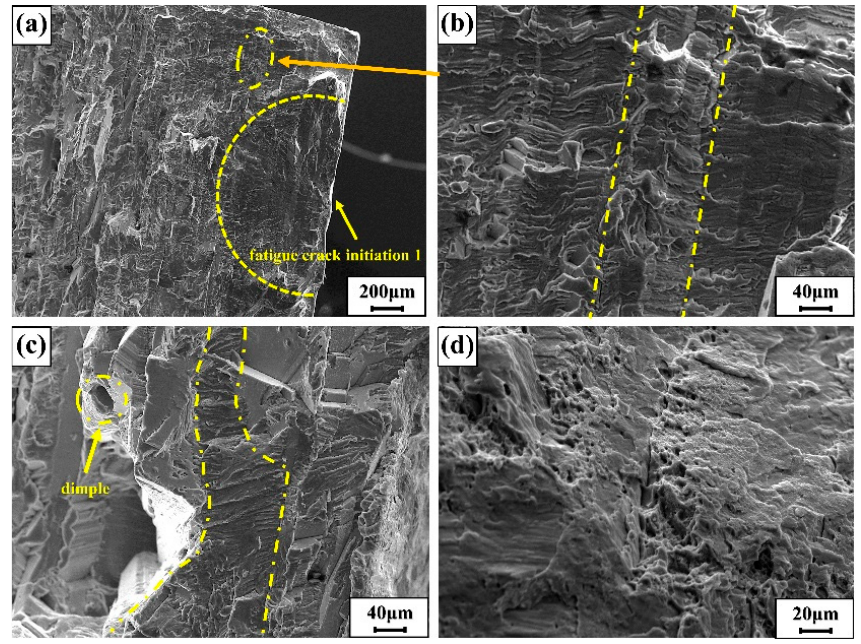
Figure 6. ( a ) Fatigue source zone 1; ( b ) partial enlarged view; ( c ) fatigue crack stable growth zone; ( d ) instantaneous fracture zone.